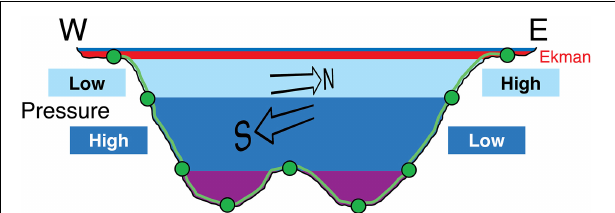
FIGURE 3 | Schematic of the geostrophic relationship between OBP (as measured by SMART pressure sensors, green dots/cables) at the western boundary of an ocean basin relative to the eastern boundary, given a net transport between the boundaries as indicated by the arrows. At the deepest depths, pressure differences on the sides of seafloor mountain ranges come into play and will also be captured by SMART cable OBP observations. Adapted from C. Hughes. Permission obtained for use of